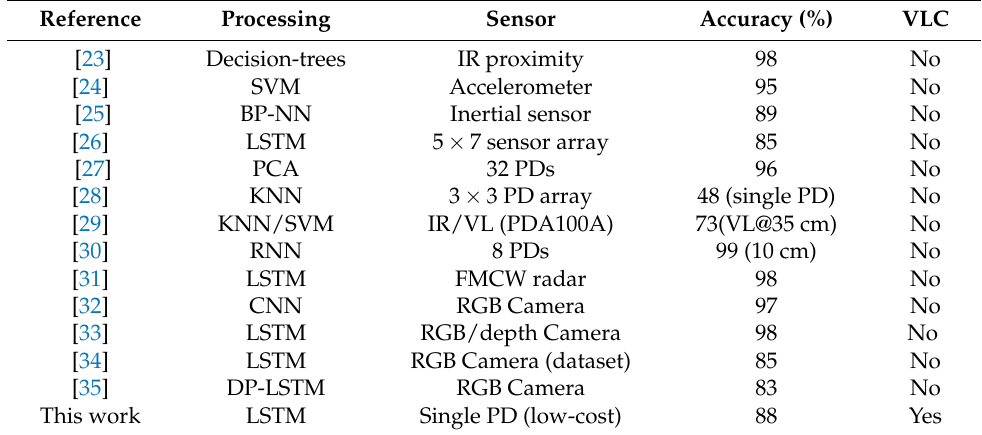
Table 1. Gesture recognition systems using machine